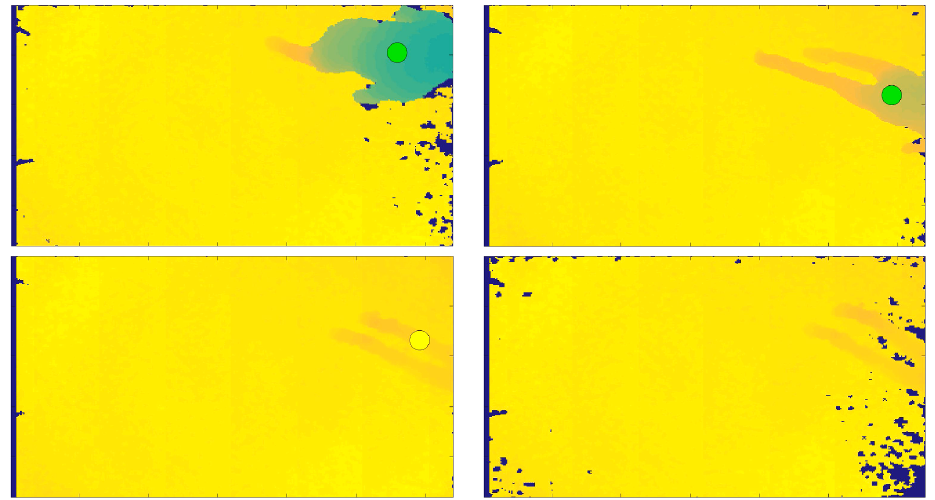
Figure 4. Fall phase of the FFELFRWK sequence simulated by ES09, where the tracking was lost because the person was out the sensor coverage area for most of their body